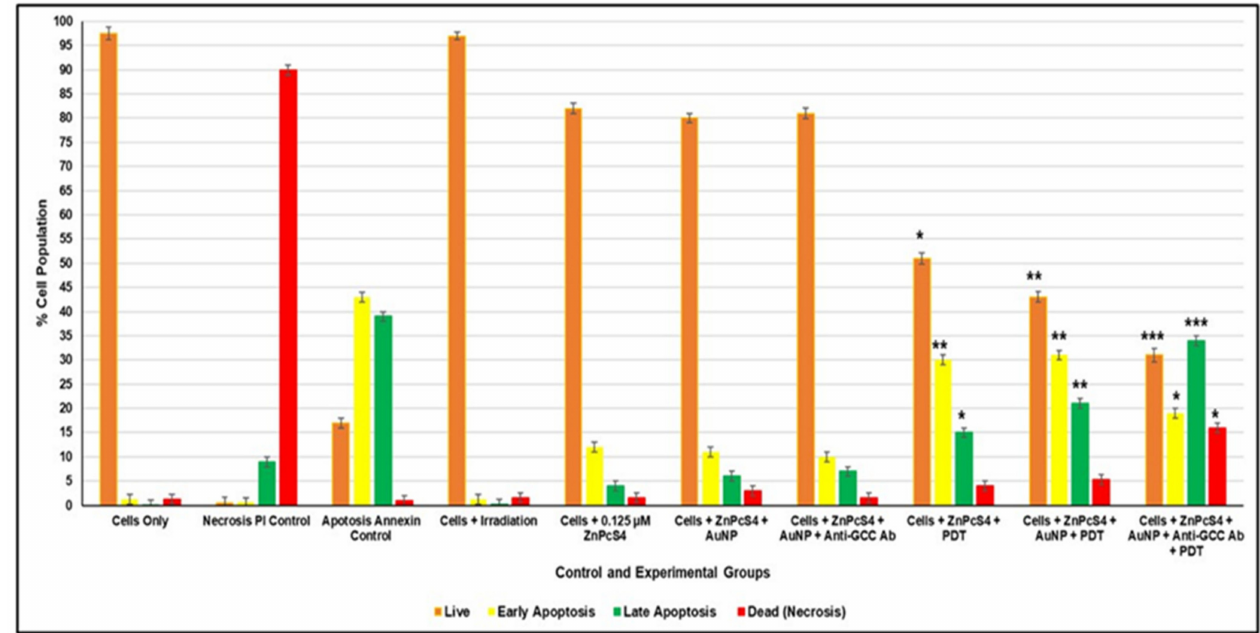
Figure 10. Percentage of different stages of cell death post-PDT using the Annexin V-FITC/PI flow cytometry detection method on various CRC control and experimental groups. The Student’s t-test was used to determine if there were significant differences between the various control and experimental groups, where values in the 95% confidence interval ( p < 0.05 *, p < 0.01 ** or p < 0.001 ***) were accepted as statistically significant. The cells-only control was used as the live cell comparable control when statistically evaluating viable cells in experimental groups, the necrosis PI control was used to assess significant cell death within experimental groups, and the apoptosis Annexin control was used to statistically compare early and late forms of apoptotic cell death within the various experimental